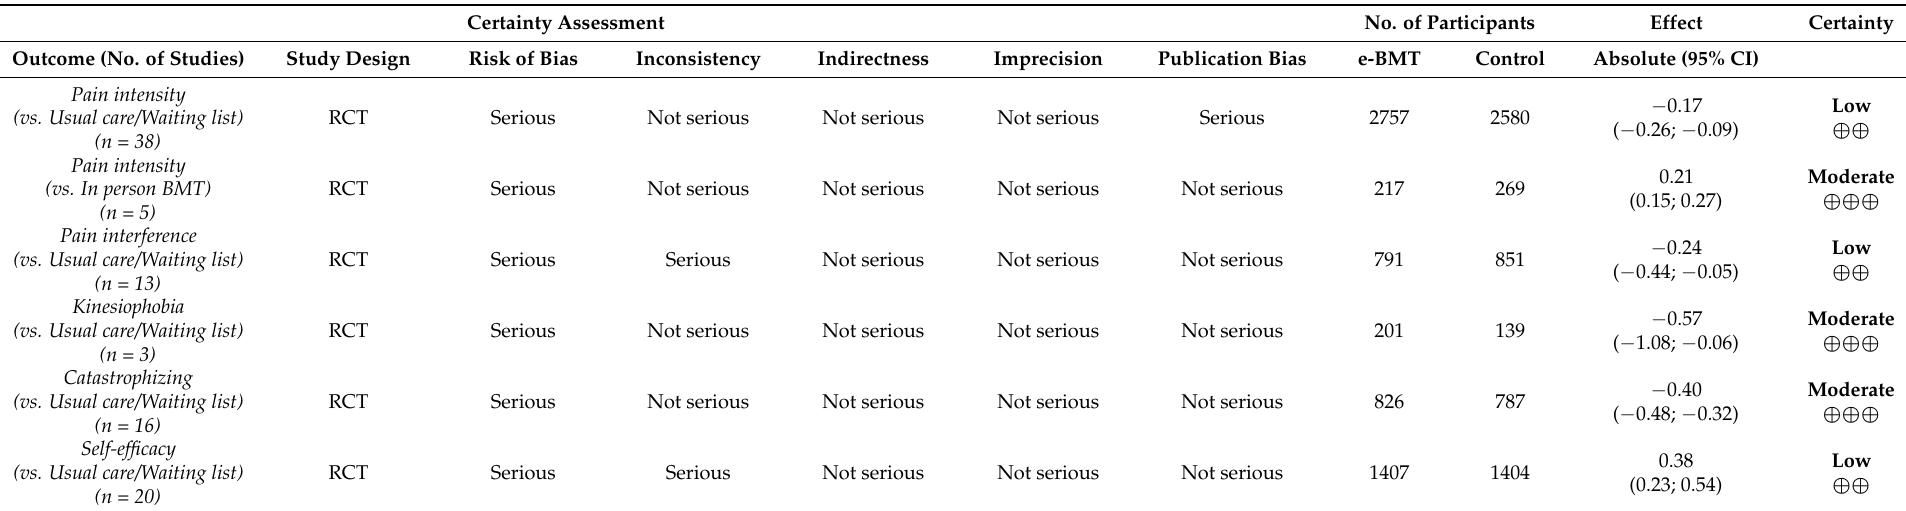
Table 2. Summary of findings and quality of evidence (GRADE).